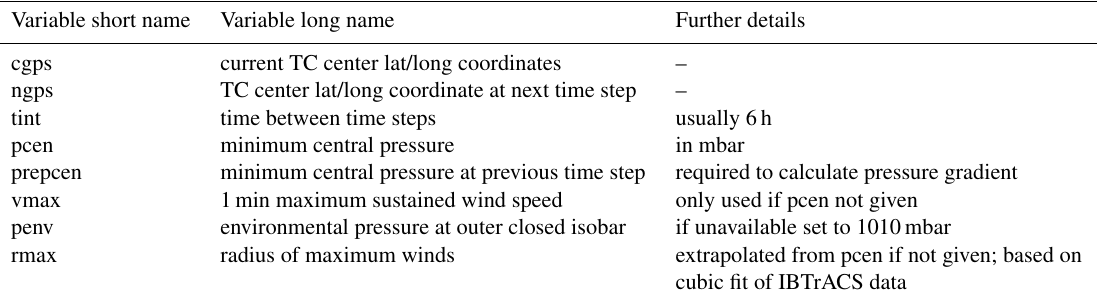
Table 2. Input variables for Holland08 wind field model as implemented in